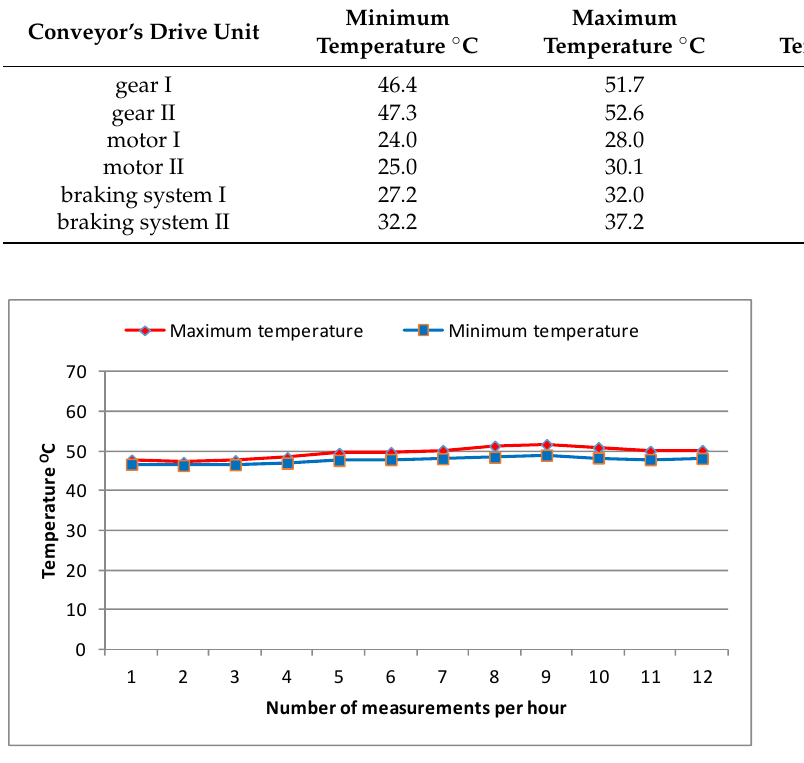
Energies 2021 , 14 , x FOR PEER REVIEW Figure 8. Temperature variation over 60 min for gear I of conveyor PT-4. Figure 8. Temperature variation over 60 min for gear I of conveyor PT-4.